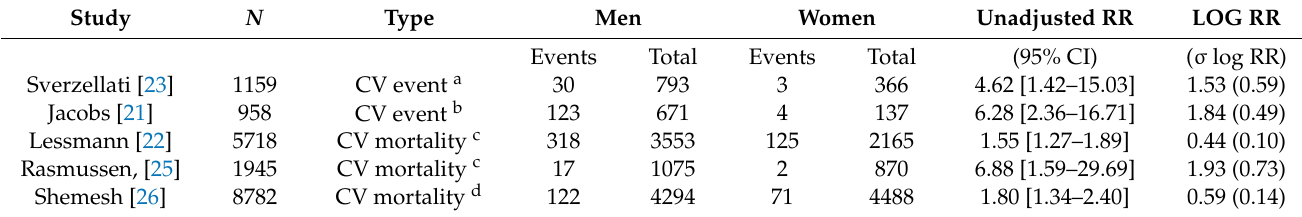
Table 5. Cardiovascular (CV) events and mortality according to